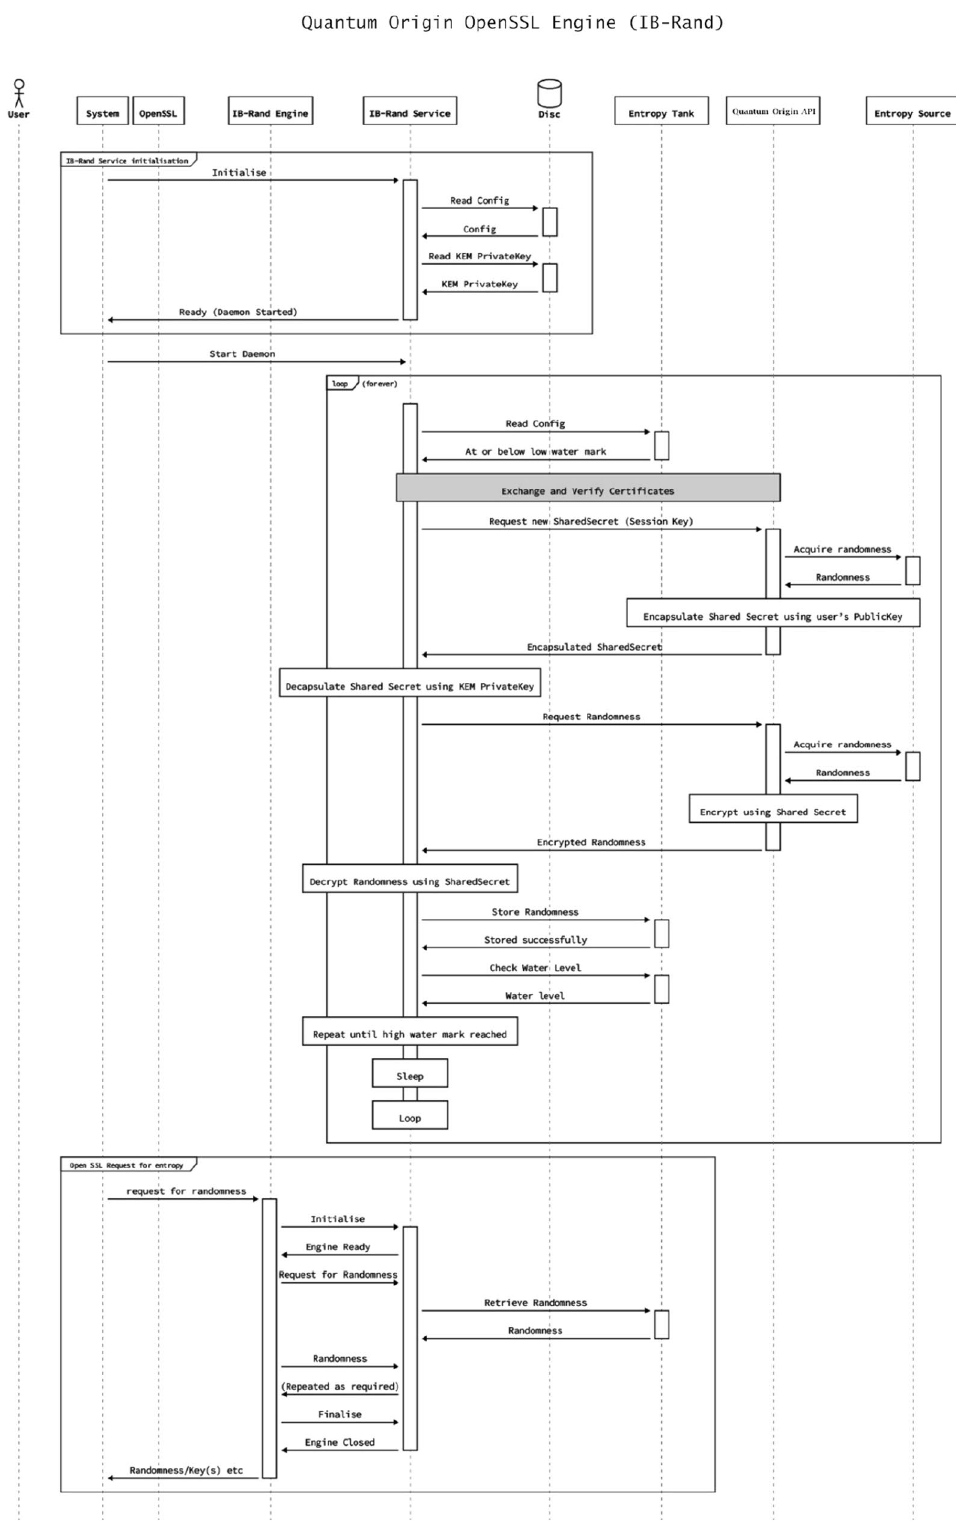
Figure 2. Detailed flows describing the generation and consumption of entropy on demand by the Open